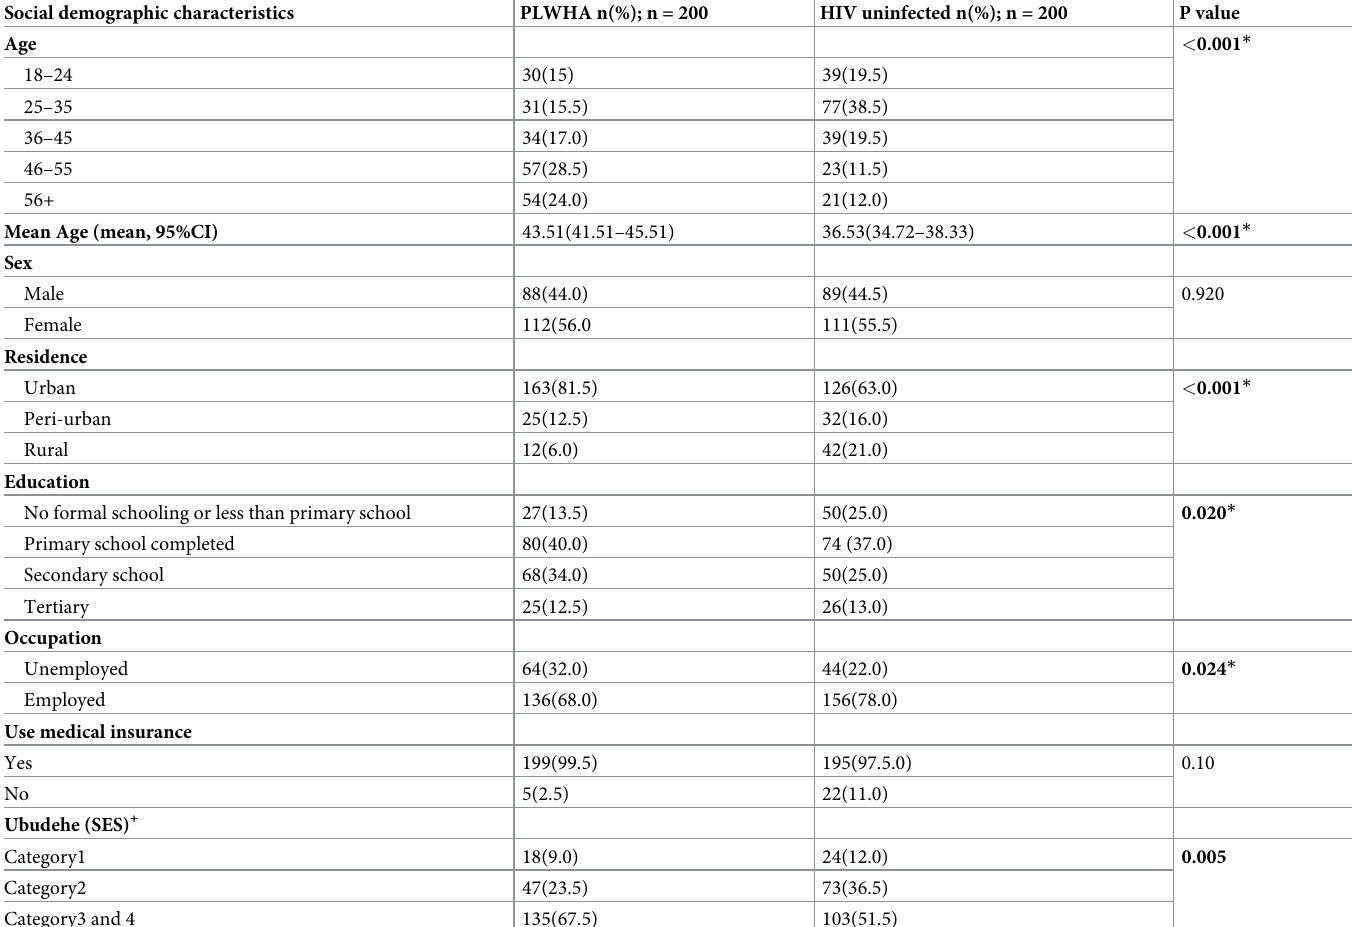
Table 1. Comparison of Socio demographic characteristics of